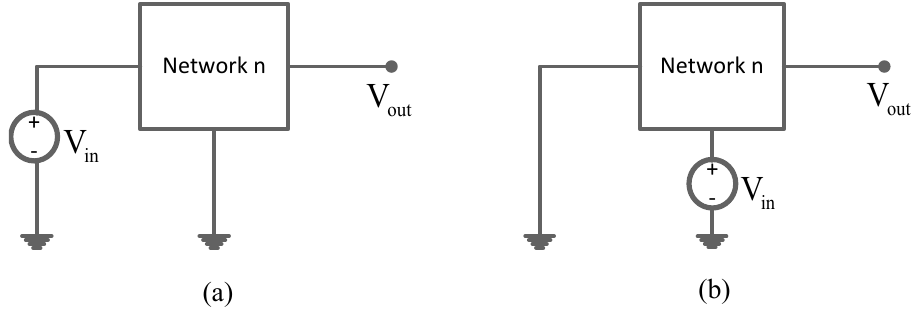
Figure 1. The complementary transformation for voltage-mode a network. ( a ) Original network; ( b ) complementary network of ( a